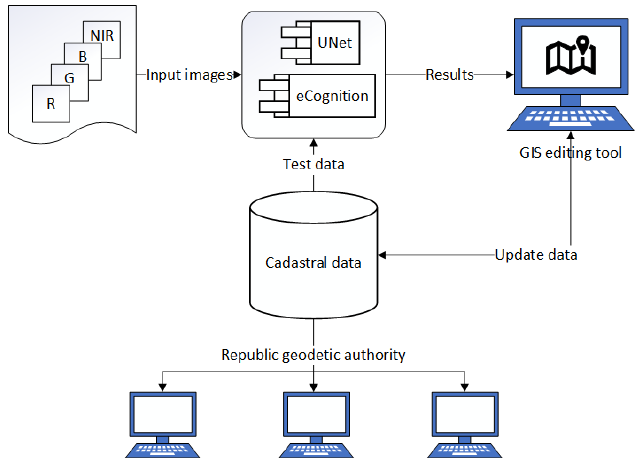
Figure 2. Overall architecture of the proposed solution.